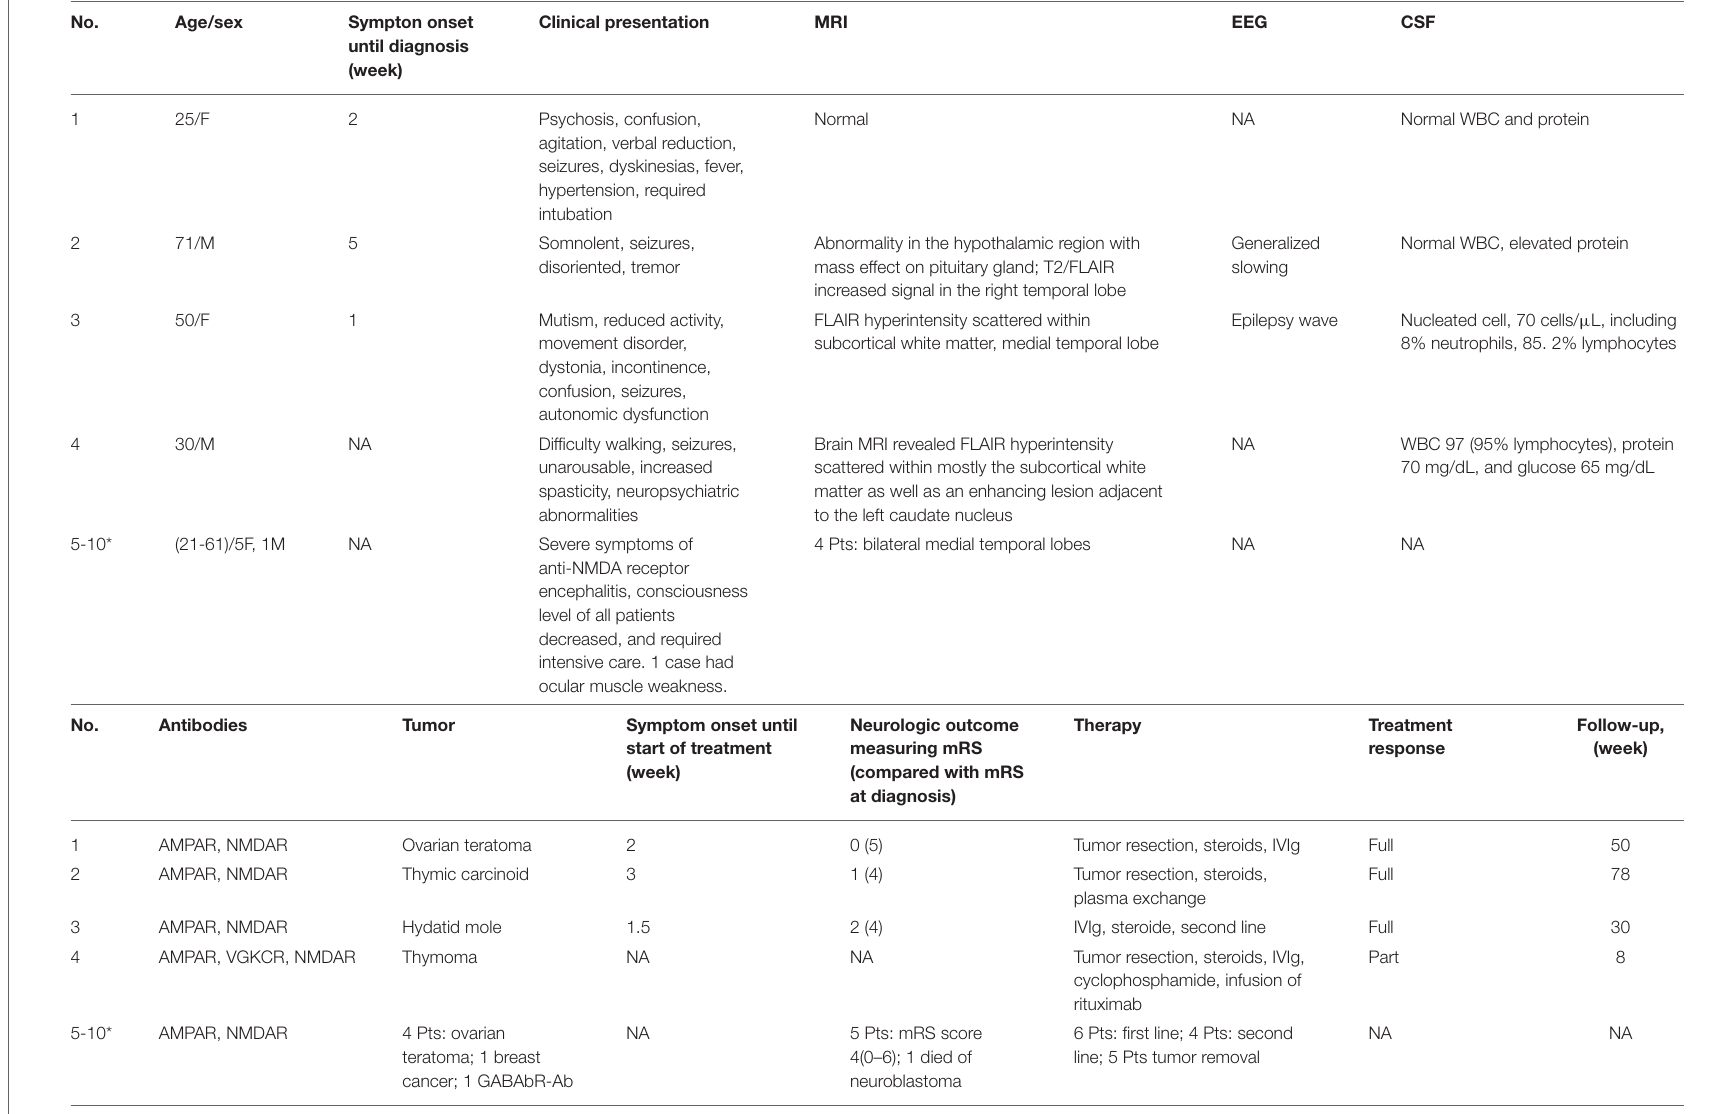
TABLE 1 | Clinical features of patients with anti-AMPA-receptor concurrent with anti-NMDA-receptor encephalitis.